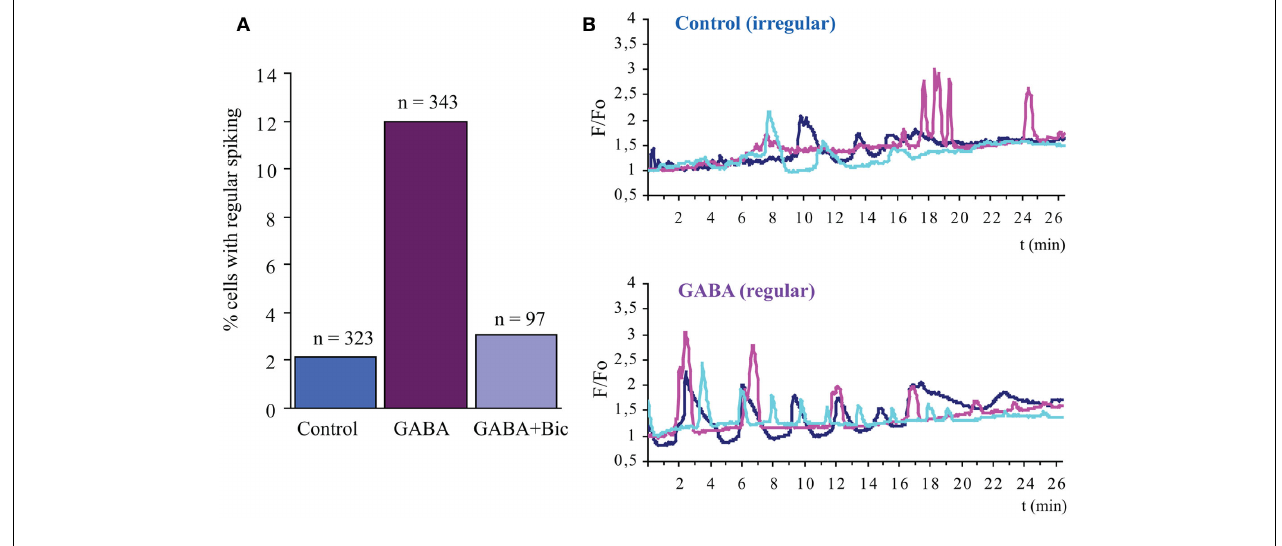
FIGURE 3 | GABA A R signaling promotes regular Ca 2 + transients on proliferating neural precursors. Analysis of spontaneous Ca 2 + transients in a population enriched in neural stem cells, purified by fluorescence activated cell sorting from the postnatal SVZ on the basis of the expression of high levels of EGFR (EGFR high cells; Ciccolini et al., 2005). After isolation the cells were plated on coverslips and maintained in medium containing EGF and FGF-2 for 2days (Cesetti et al., 2009). Upon loading with the Ca 2 + indicator fluo-3, in control conditions the EGFR high cells displayed a very low incidence